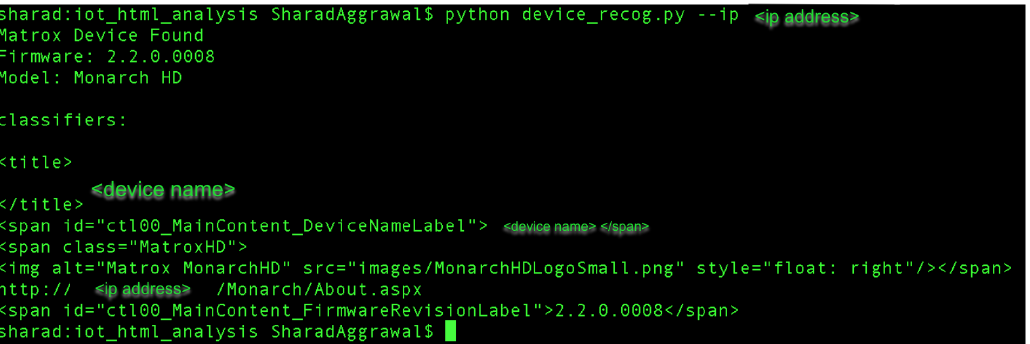
Figure 4. Sample working of Web-IoT detection (WID)